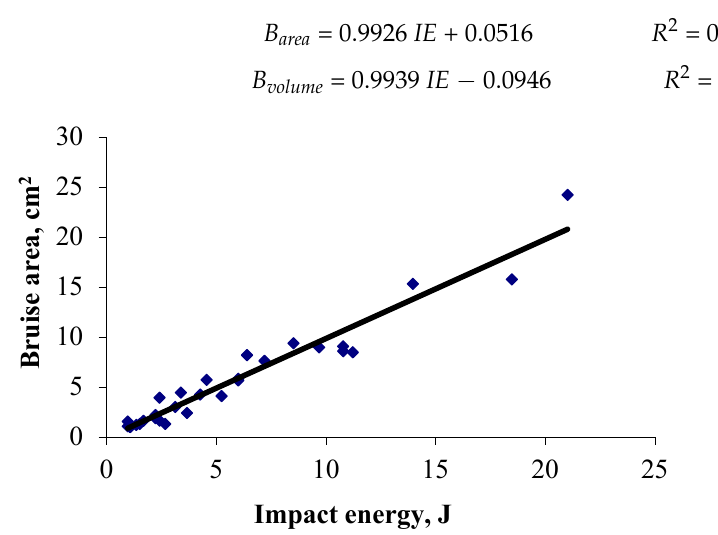
Figure 10. Bruise volume vs. storage time at different surface for cantaloupe fruit.